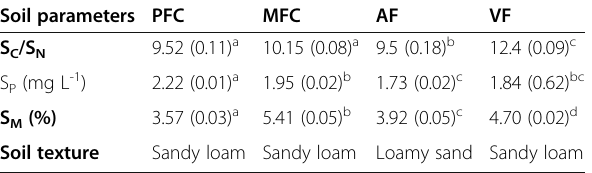
Table 1 Soil physical and chemical factors of four land uses of the semiarid region of